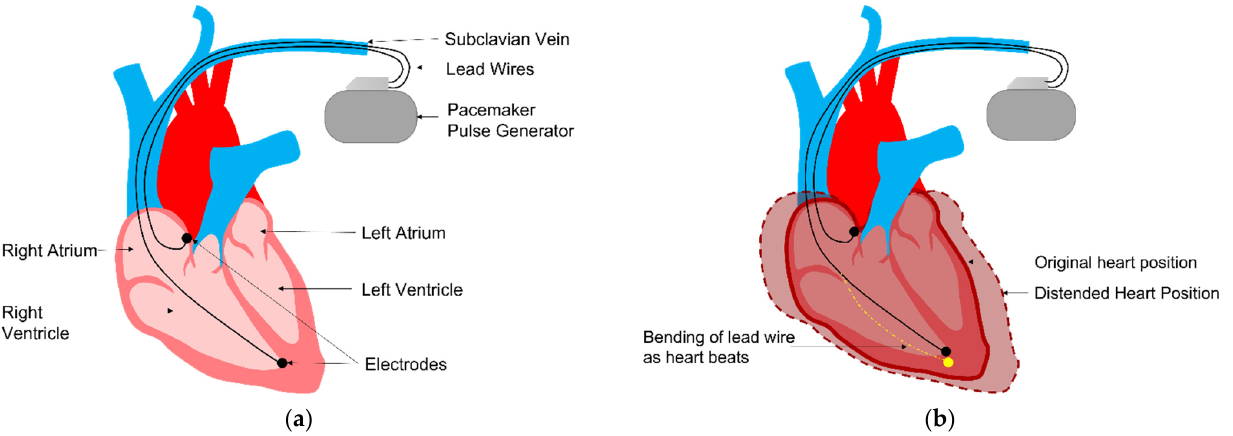
Figure 2. Schematic showing how the pacemaker is implanted in the heart. ( a ) Pacemaker implanted in the body with lead wires running in the subclavian vein and attaching to the right atrium and ventricle. ( b ) Schematic showing lead wire bending as the heart distends during beating motion.